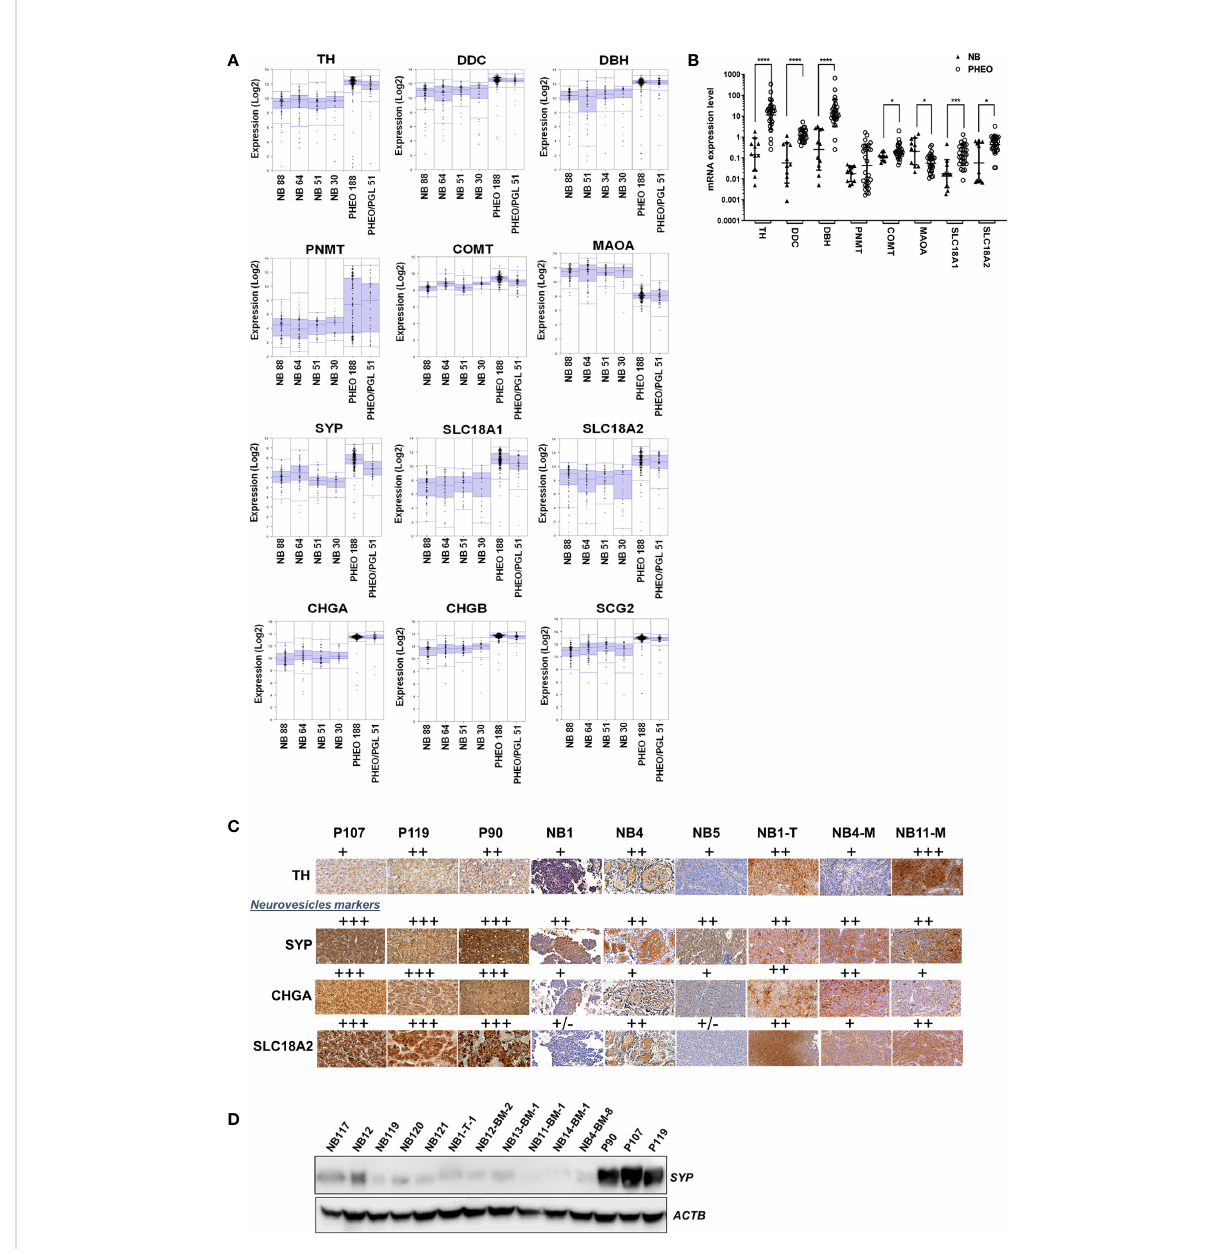
FIGURE 2 Expression level of genes involved in CATs metabolism and NV markers in NB and PHEO. (A) Expression levels (log2) of the indicated genes in 4 NB transcriptomic datasets (Versteeg n=88, Hiyama n= 51, Delattre n=34, Lastowska n=30) and 2 PHEO/PGL datasets (Favier n=188, and Korpershoek n=51) analyzed by microarray using the R2: Genomics Analysis and Vizualization Platform (http://r2.amc.nl, MegaSampler analysis: Human Genome U133, Plus 2.0; MAS5.0 data normalization). (B) mRNA quanti fi cation by RT-qPCR of the main enzymes involved in CATs metabolism and NV markers from NB (n=10) and PHEO/PGL (n=28) tissues. Individual values and geo means ± SD are plotted and analyzed with a non-parametric Mann-Whitney test. p values are reported only when statistically signi fi cant (<0.05), *= p <0.05, ***= p <0.001, ****= p <0.0001). The values for NB were already published in another study comparing primary NB and NB-PDX (17) (Supplementary Table 1). (C) Representative images of IHC staining the detection of TH, SYP, CHGA and SLC18A2 protein expression on three PHEO/PGL tissue: P90, P107, P119, three NB biopsies from patients: NB1, NB4 and NB5 and three NB-PDX: NB1-T-1, NB4-BM-8, NB11-BM-1. The results were semi-quantitatively scored (+, faint; ++, moderate; +++, strong). (D) Immunoblotting for the detection of SYP in tissue samples from fi ve NB biopsies (4 after chemotherapy and one, sample NB-121 at the time of diagnosis), six NB-PDX : NB1-T-1, NB12-BM-2, NB13-BM-1, NB11-BM-1, NB14-BM-1, and NB4-BM-8, and from three PHEO/PGL: P90, P107, P119. Volumes loaded were 10µl from a 20% wt/vol extracts. ACTB was used as loading